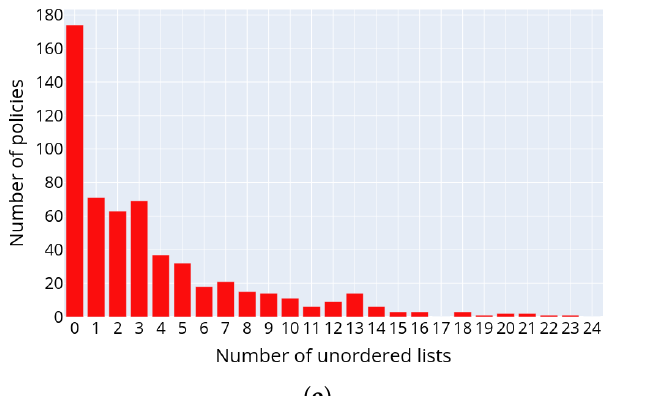
Figure 5. Histogram of the distribution of data structuring elements in the text of privacy policies: headings ( a ), paragraphs ( b ), tables ( c ), numbered lists ( d ) and unnumbered lists ( e ).